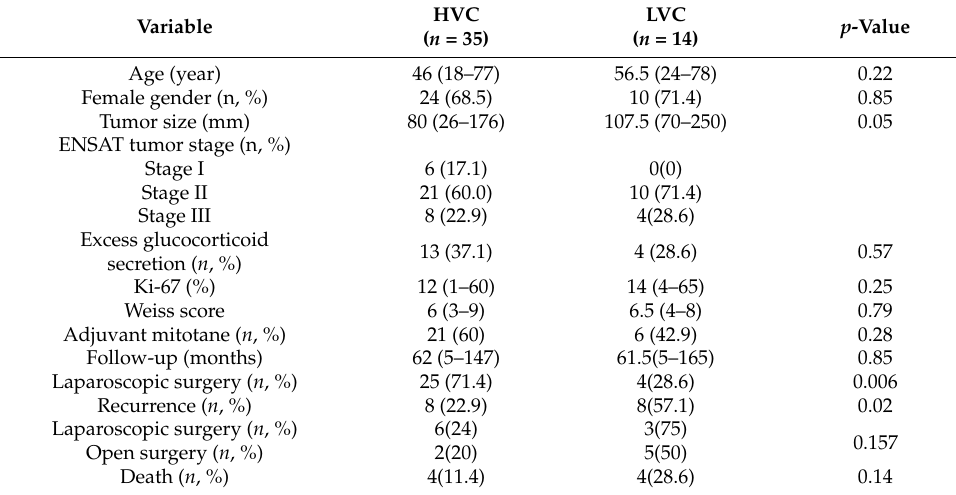
Table 1. Patient demographics and clinical characteristics.